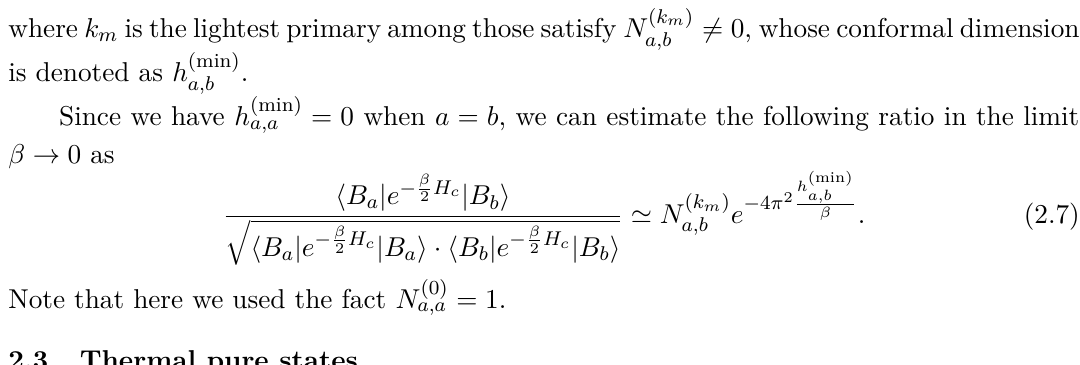
Figure 1 . A sketch of cylinder amplitude from the viewpoint of closed string (left) and open string